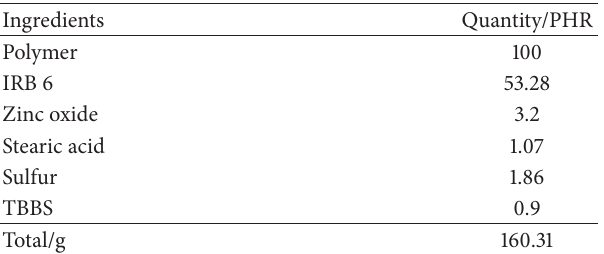
Figure 6: Mooney viscosity versus molecular weight of high cis -1,4- BR. Table 3: Basic formulation employed in the preparation of blends for tires.